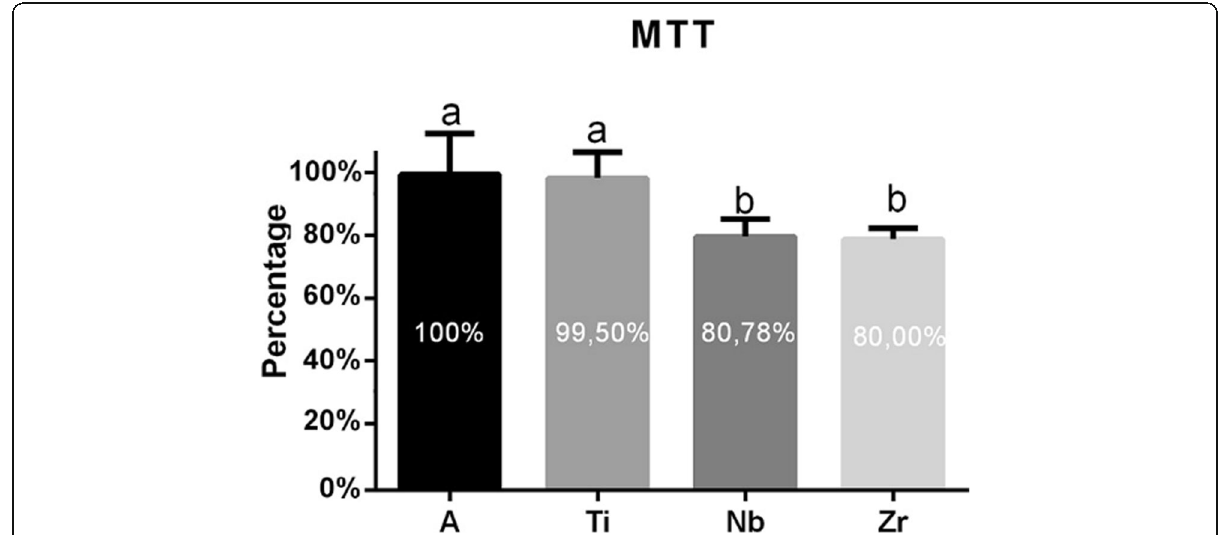
Fig. 3 Graph showing (a) titanium alloy and Titanium cp with very similar results regarding cell viability and with higher cell viability when compared with the other samples. Statistical difference (a/b) were observed in relation to the groups of the basic elements ( p <